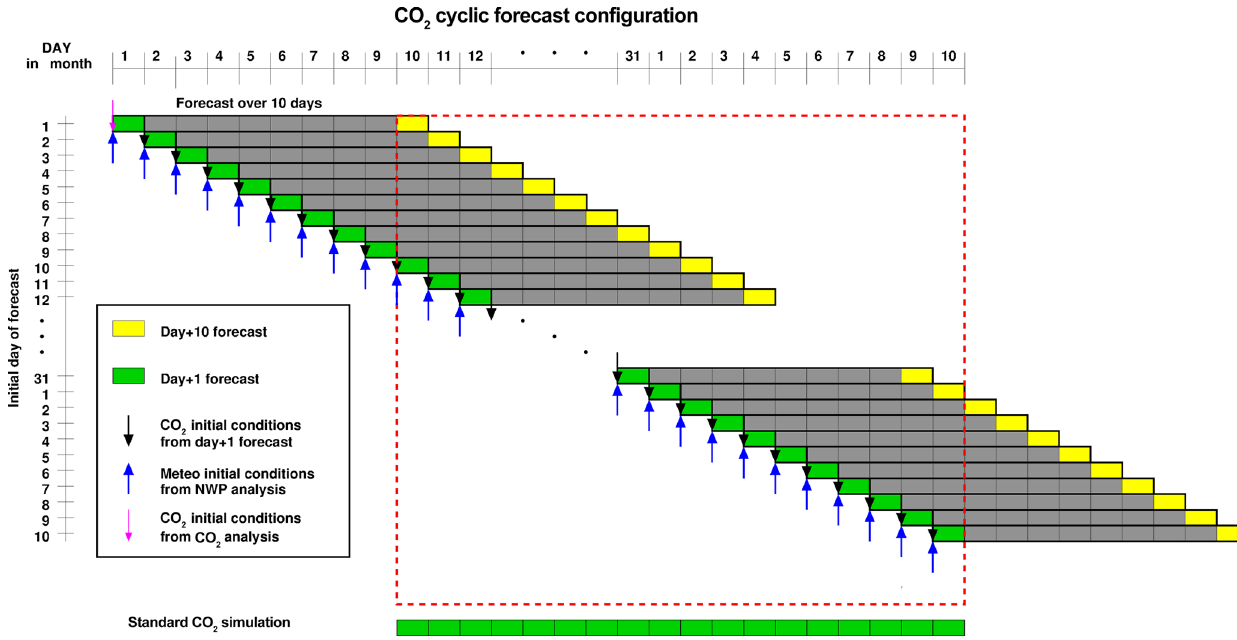
Figure 3. Schematic of CO 2 simulations with cyclic forecast configuration with 10d forecasts initialised every day from 1st of the month to the 10th day of the following month. Initial conditions are depicted by arrows (see legend), and the period of evaluation in which several forecast lead times can be compared is delimited by the red dashed line. The standard CO 2 simulations are composed by a series of 1d forecasts as shown by the green